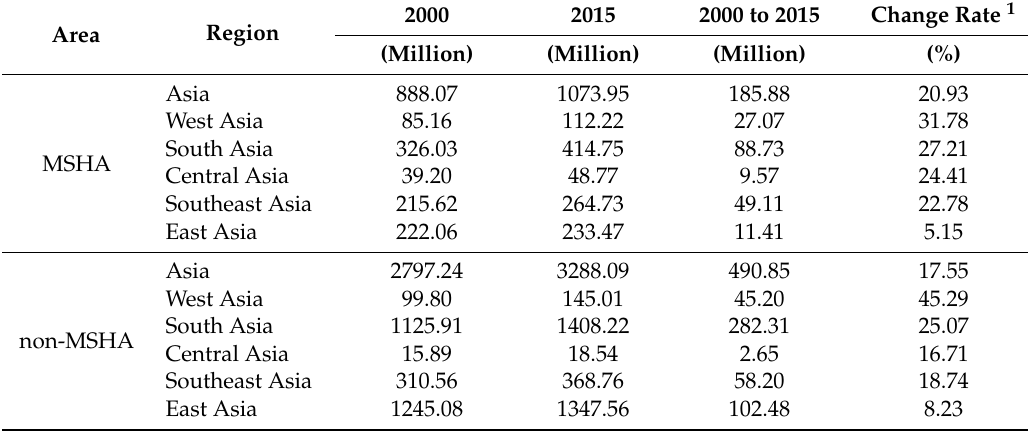
Table 2. Changes in the total population of Asia from 2000 to